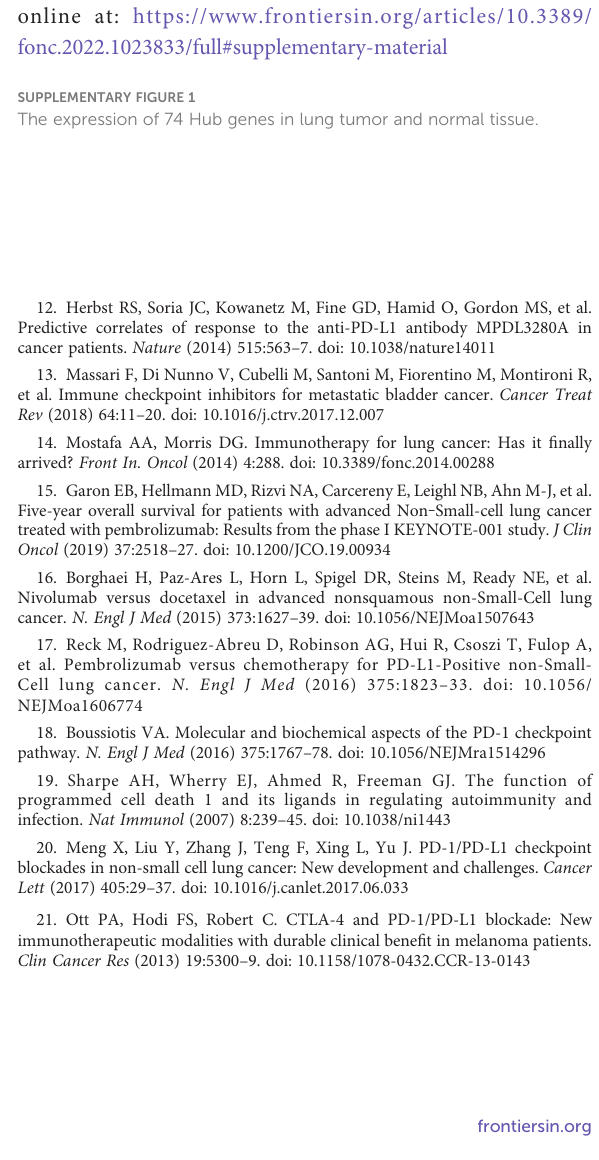
SUPPLEMENTARY FIGURE 1 The expression of 74 Hub genes in lung tumor and normal